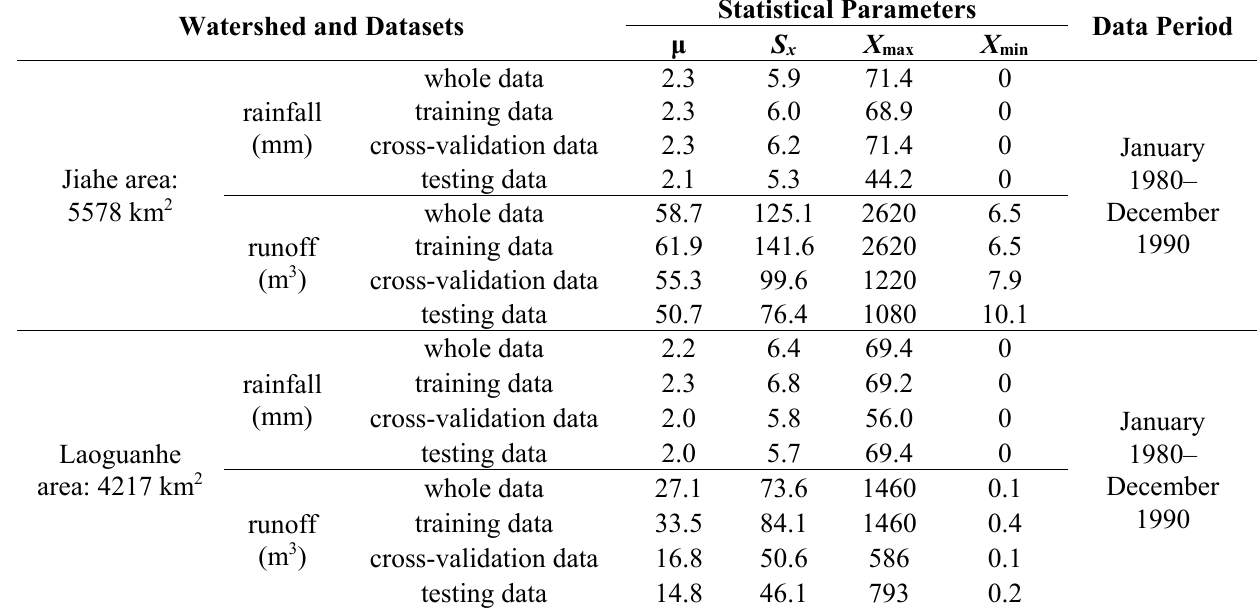
Table 1. List of the watershed statistical